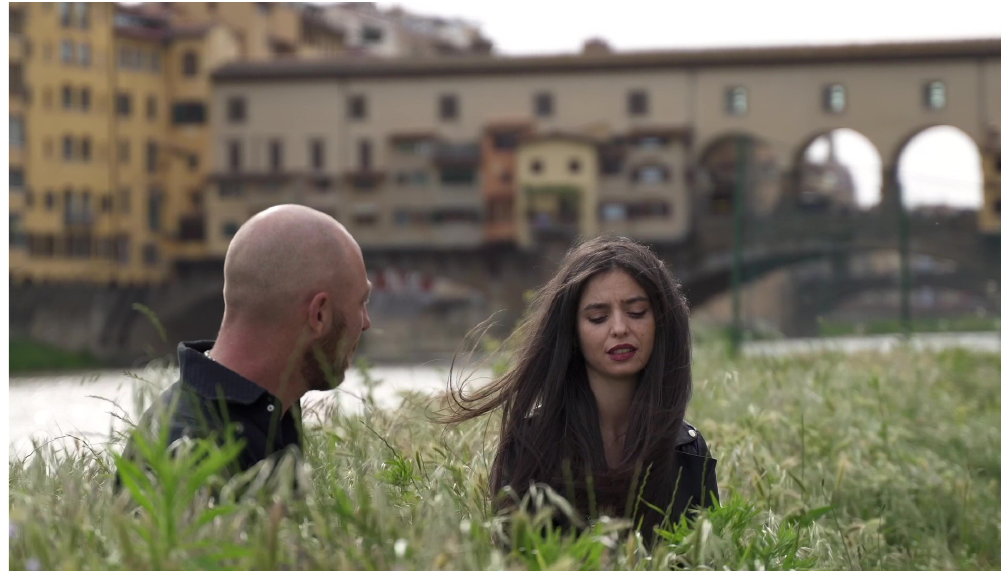
Fig. 4 F. Pinzani and a performer